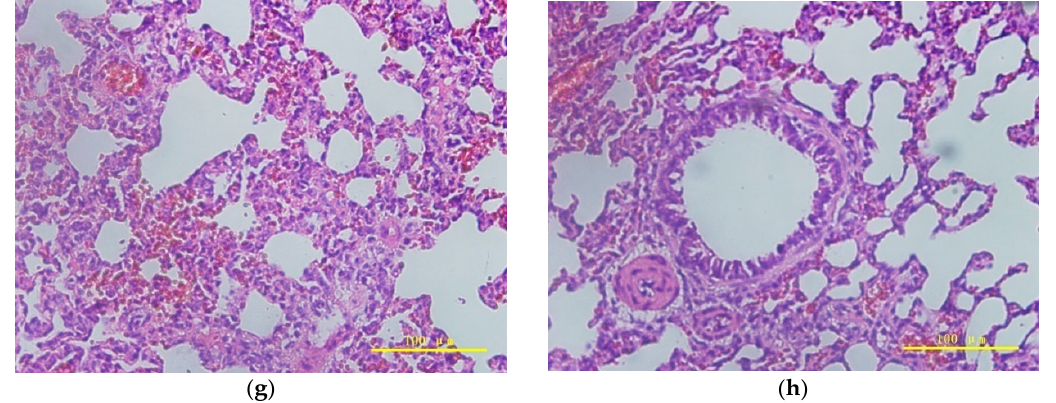
Figure 8. Histological examinations of lung tissues under different treatments: ( a ) pulmonary alveoli of the untreated; ( b ) trachea of the untreated; ( c ) pulmonary alveoli of air; ( d ) trachea of air; ( e ) pulmonary alveoli of PLLA PMs; ( f ) trachea of PLLA PMs; ( g ) pulmonary alveoli of LPS; and ( h ) trachea of LPS.